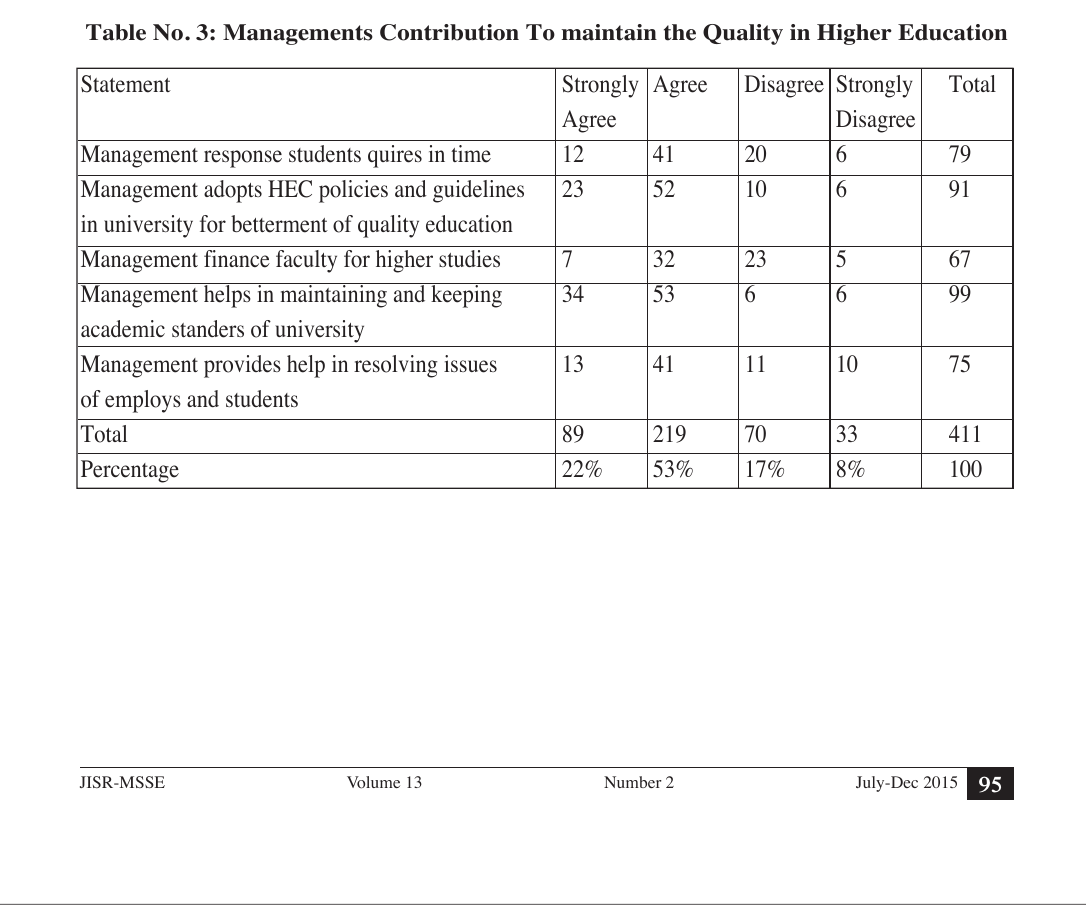
Table No. 3: Managements Contribution To maintain the Quality in Higher Education